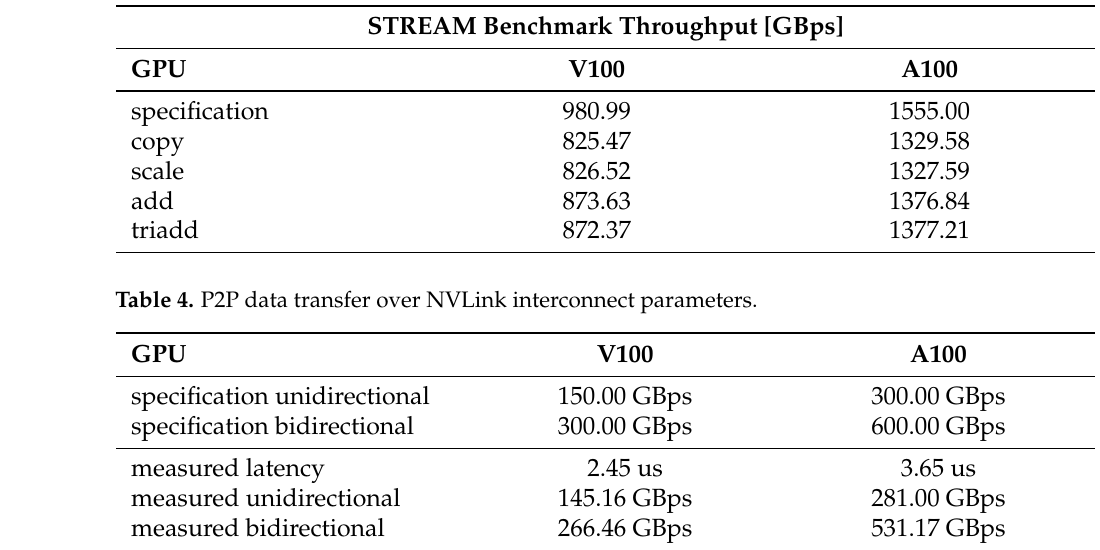
Table 3. V100 and A100 memory throughput measured by the STREAM benchmark compared to specification.